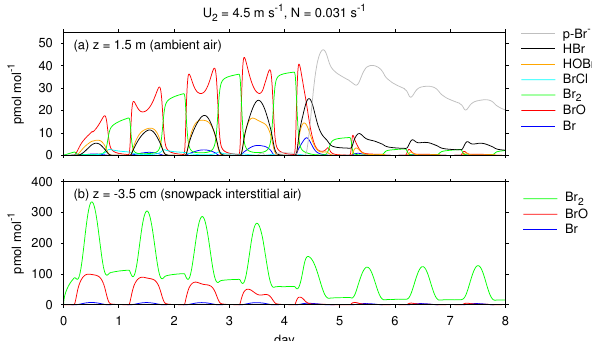
Fig. 6. Temporal evolution of major bromine species at the height of (a) z = 1 . 5m (ambient air) and (b) z = − 3.5cm (snowpack intersti- tial air) from amodel run with U 2 = 4 . 5ms − 1 and N = 0 . 031s − 1